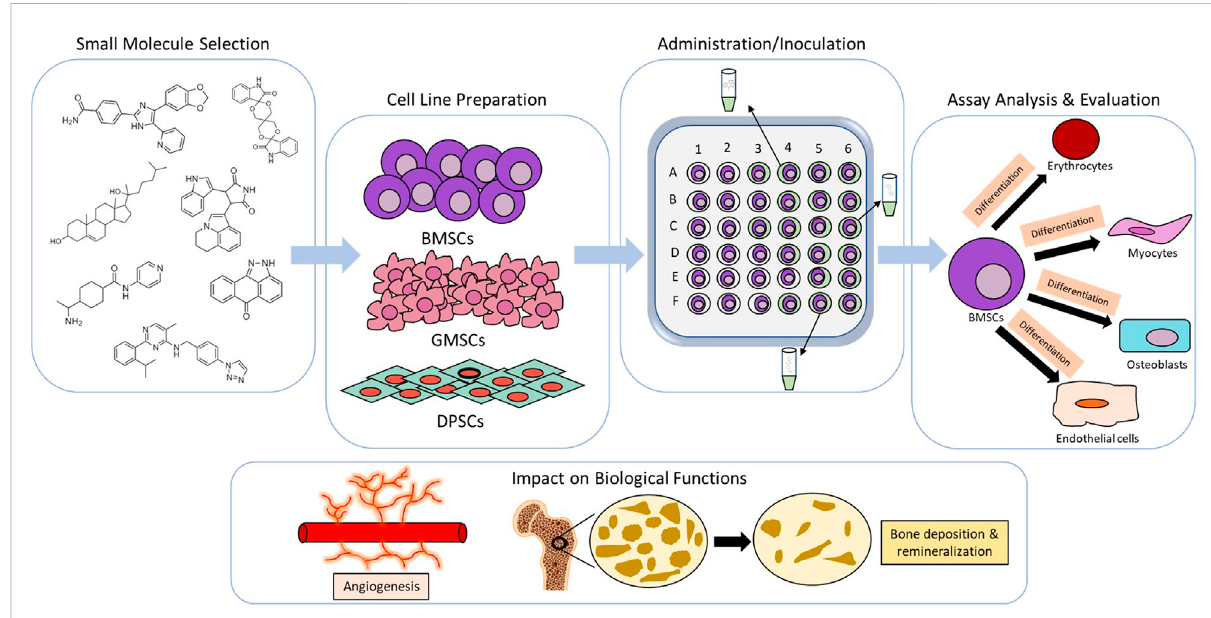
FIGURE 1 Example methodology of in vitro analysis for craniofacial and dentoalveolar tissue engineering. Meticulous selection of small molecules with favorable osteogenic properties and stem cell lineages from craniofacial or dentoalveolar tissues. Media imbued with small molecules are typically inoulated with stem cells and later assessed for expression of osteogenic markers and cellular differentiation. Cumulative change in biological functions (e.g.,angiogenesis and bone mineralization) are then